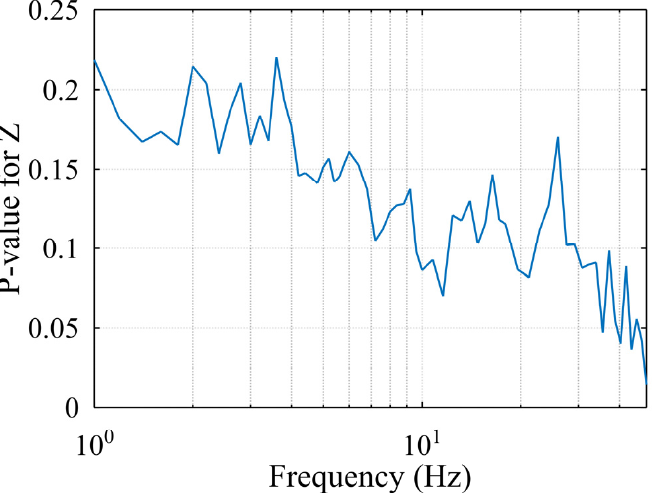
Figure 20. Variation in the p -value along the frequency range .